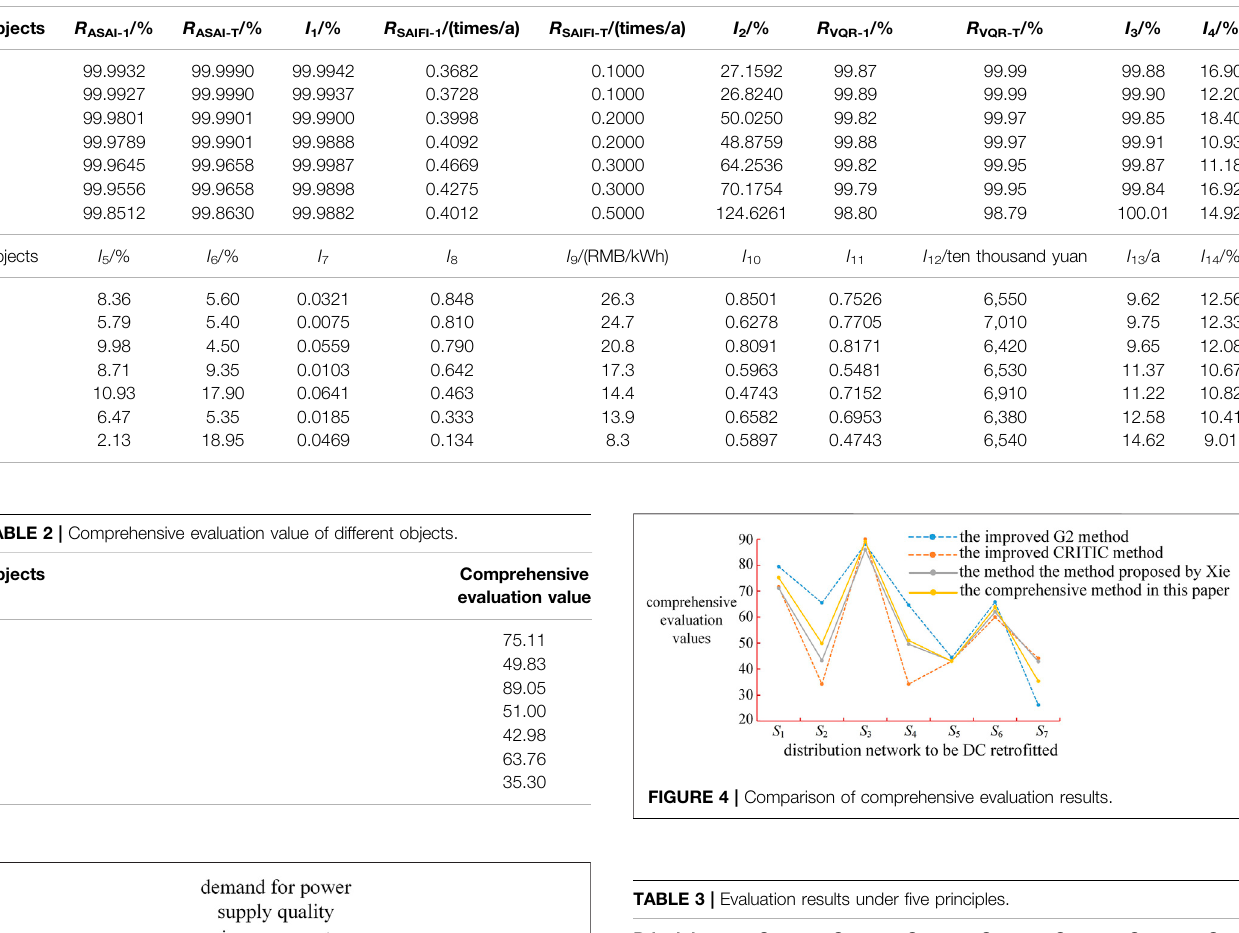
TABLE 1 | Index data of each distribution network.